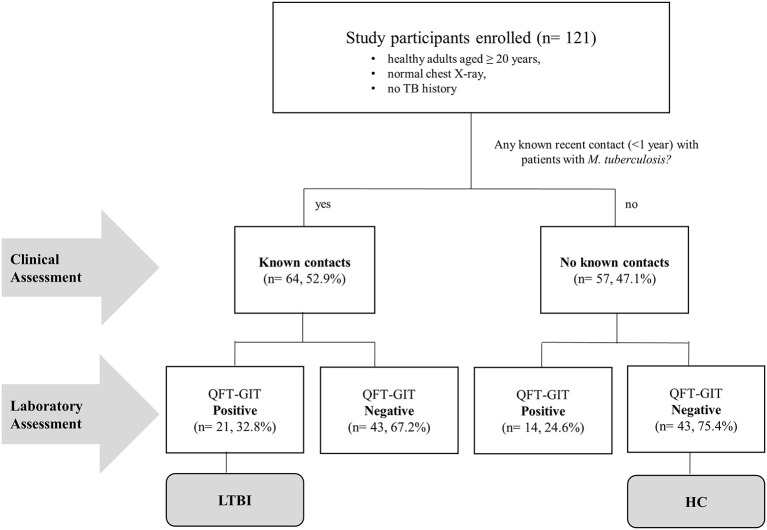
Flow chart of study participants enrolled. A total of 121 Korean healthy adults aged more than 20 years old with normal chest x-ray results and without any tuberculosis history agreed to participate in the study at the Severance Hospital, Seoul. Sixty-four participants had had known contacts with TB patients within the past year. The other participants had had no known previous contacts with TB patients. In addition to clinical evaluation in terms of exposure to M. tuberculosis, we tested all study participants with QFT-GIT test for diagnosis of TB infection. Of the known TB contacts, 32.8% (n = 21) were QFT positive and defined as individuals with LTBI. In those without known TB contact, 75.4% (n = 43) were QFT negative, and were defined as healthy controls (HC) in this study.